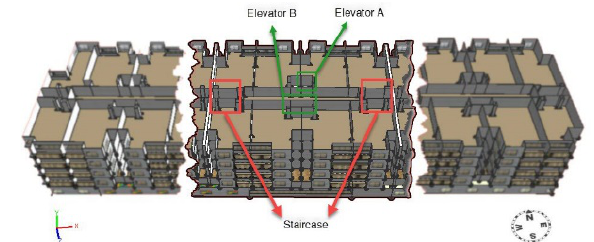
Figure 11. The location of elevators and stairs in the case study